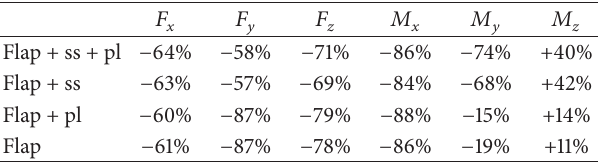
Table 2: Reductions of hub loads with feedback (Drees synthesis).